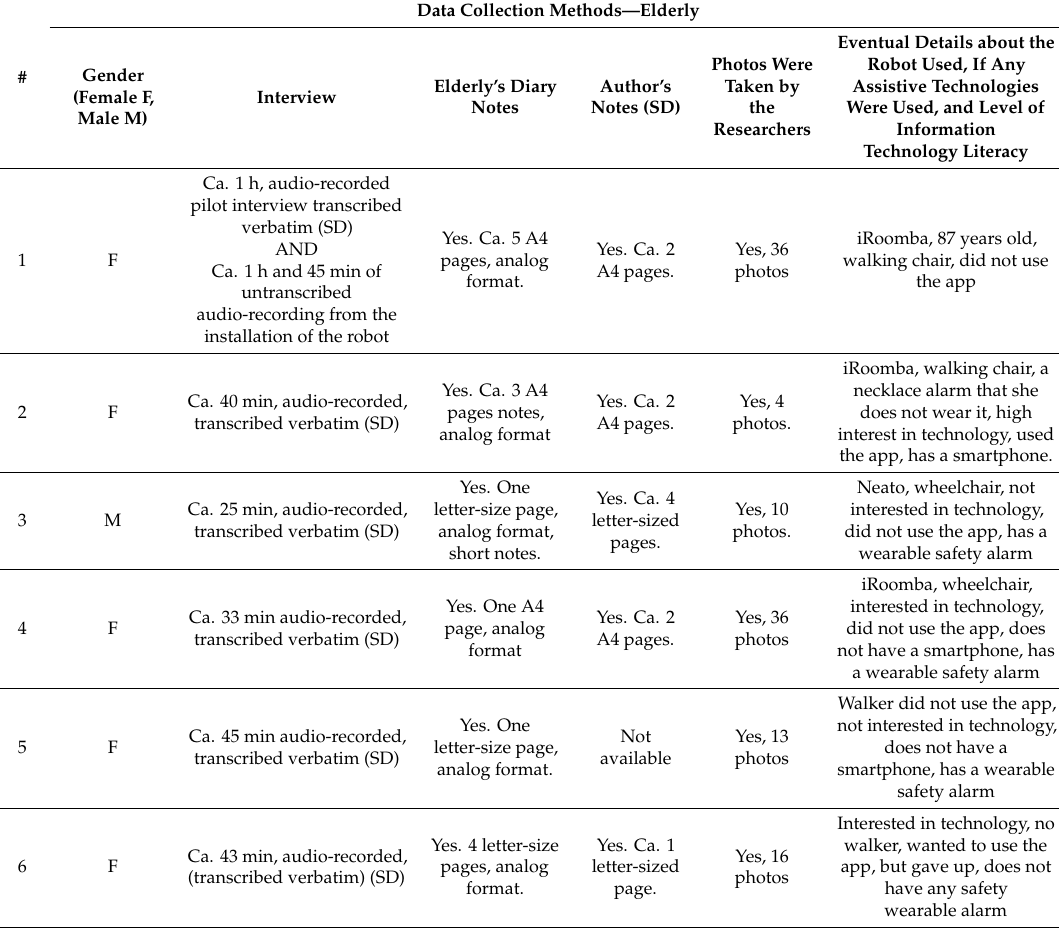
Table 3. Overview of the data collected from the elders